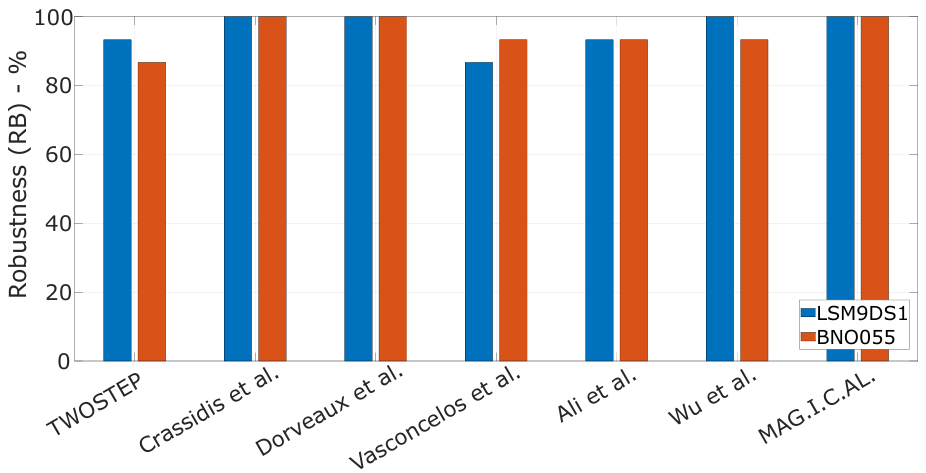
Figure 6. Performance characteristics of the presented algorithms using multiple datasets of real data from two different commercial magnetic field